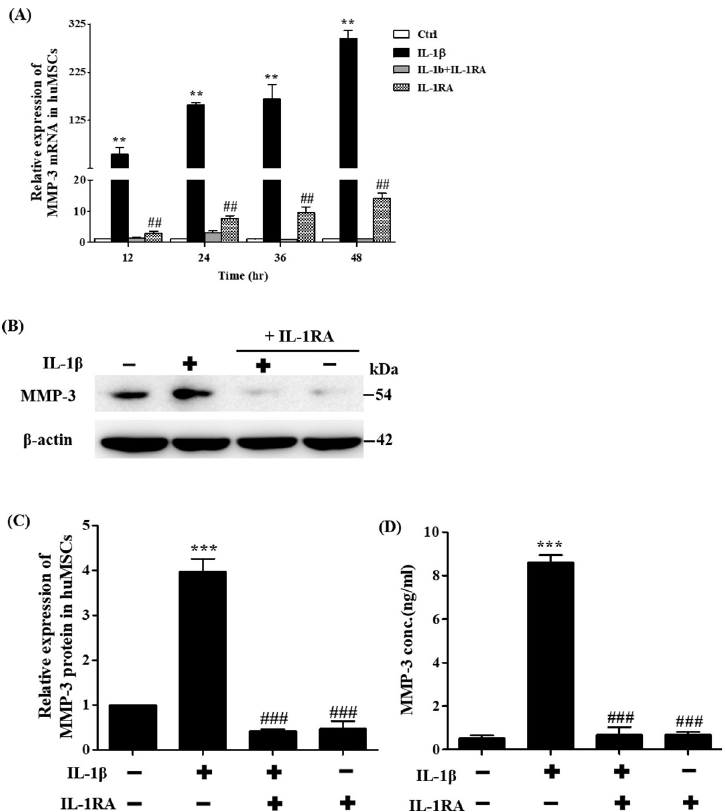
Fig 2. Effects of IL-1 β in hUCMSCs on MMP-3 RNA and protein levels. (A) Quantitation of changes in gene expression of MMP-3 detected by real-time PCR after IL-1 β inhibitor IL-1RA (2 μ g/ml) pre-treatment and stimulation with IL-1 β for 12–48 hours. (B) Example of Western blot results of the MMP-3 (54 kDa) from the lysates of cells treated with IL-1 β and IL-1RA. The full-length Western blots was showed in S2 Fig. (C) Quantitative graphs of the Western blot results of MMP-3 protein expression of (B). (D) MMP-3 protein expression was measured using ELISA, pre-treatment with IL-1RA at concentration of 2 μ g/ml and stimulated with IL-1 β for 36 hours. Data are shown as the mean ± SD (n = 3, �� P < 0.01, ��� P < 0.005 versus control cells, #p < 0.05, ##p < 0.01 versus IL-1 β treated cells).